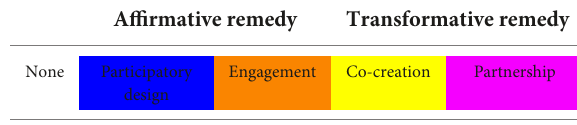
TABLE 2 Social injustice remedy